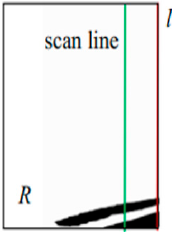
Figure 8. Determining the upper contour of H b .